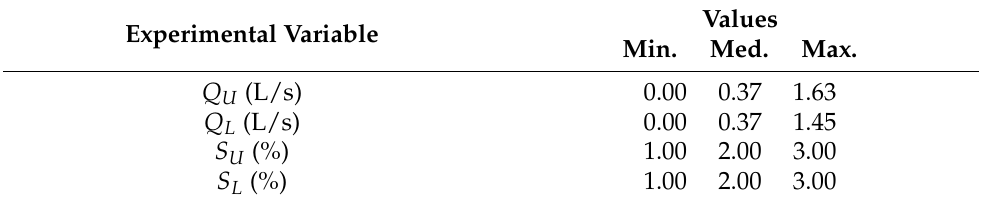
Table 1. Experimental variables and dimensional values